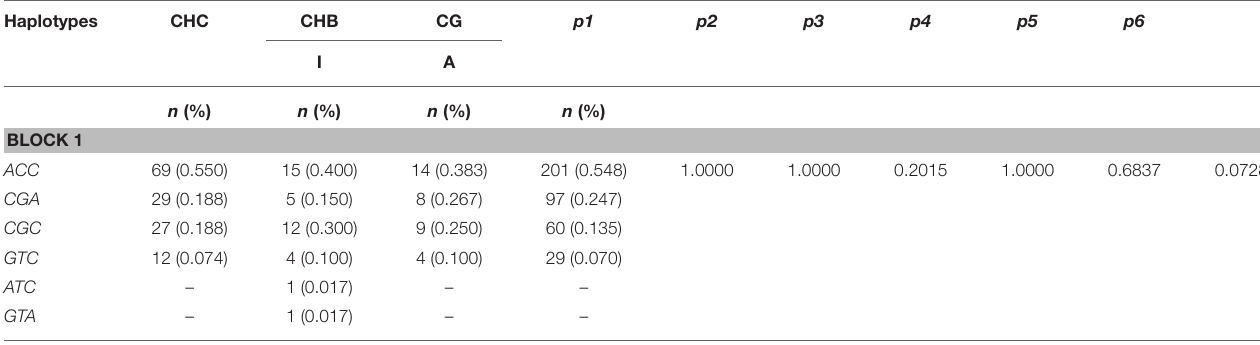
TABLE 3 | Haplotype frequencies of polymorphisms of the FOXP3 gene promoter region ( − 924A > G, − 2383C > T, and − 3279C > A ) in patients with chronic hepatitis B and C virus infections.